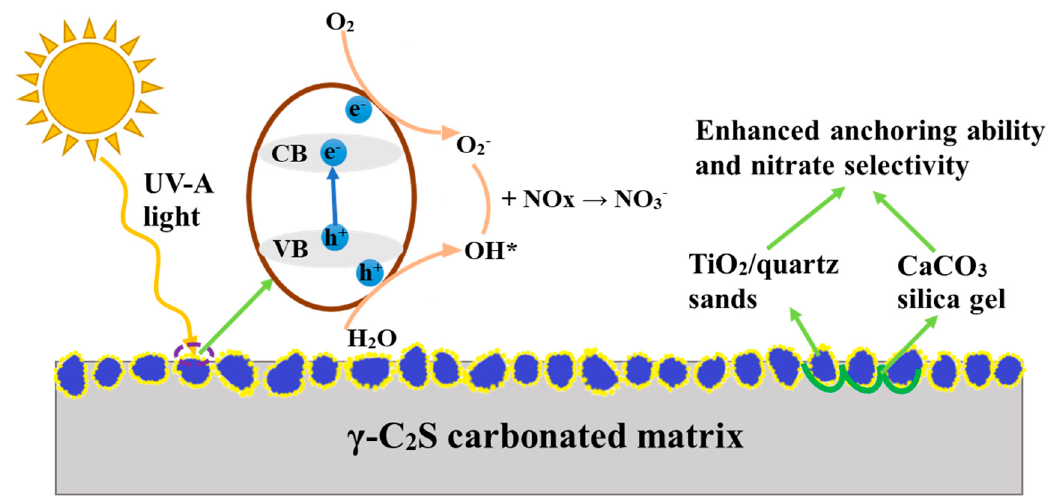
Figure 1. The schematic of De-NOx via photocatalytic oxidation.